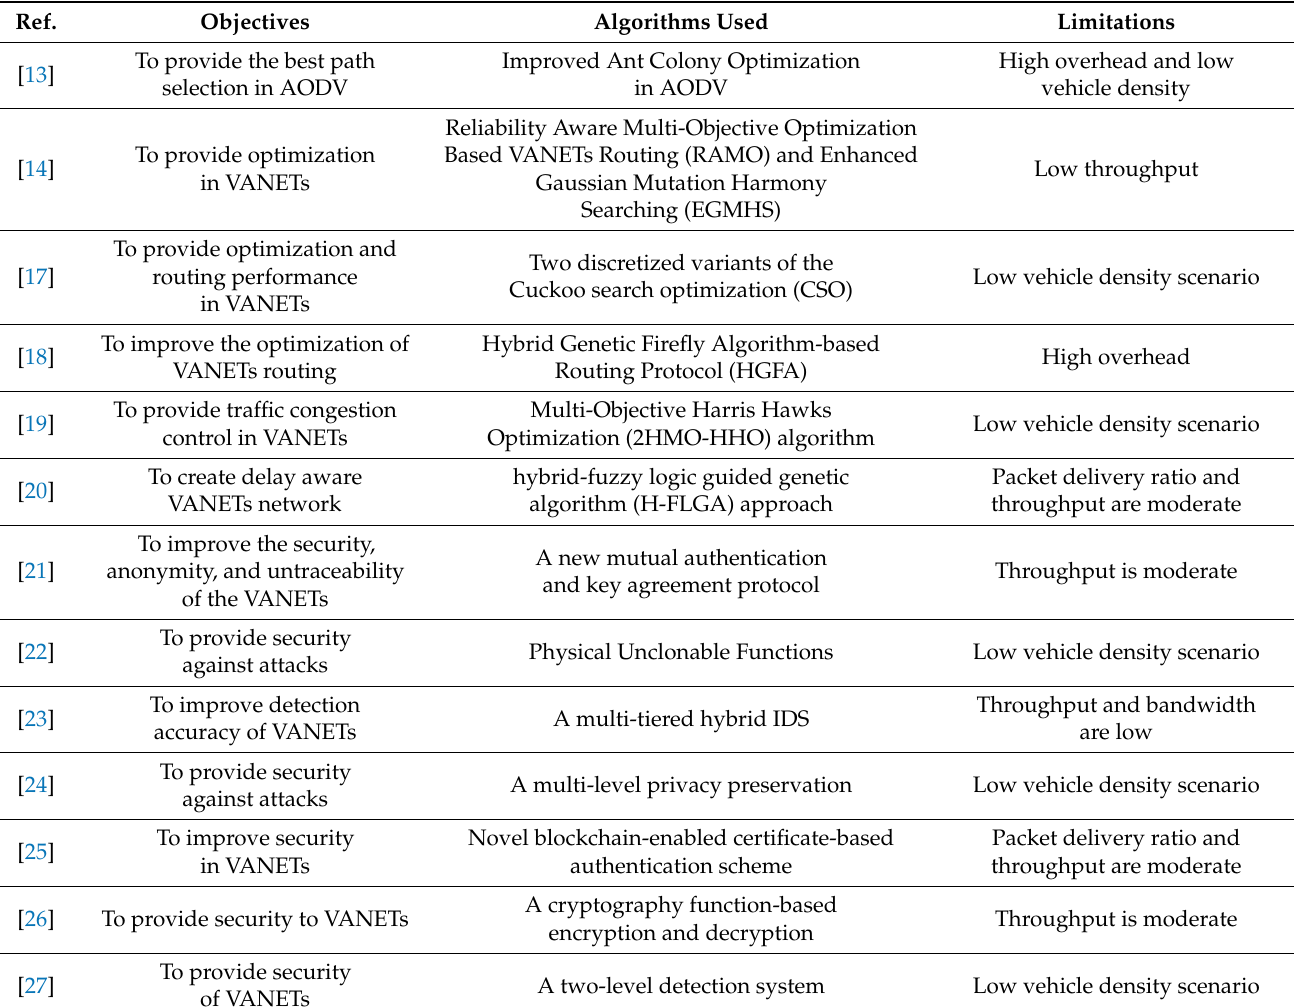
Table 1. Summary of related